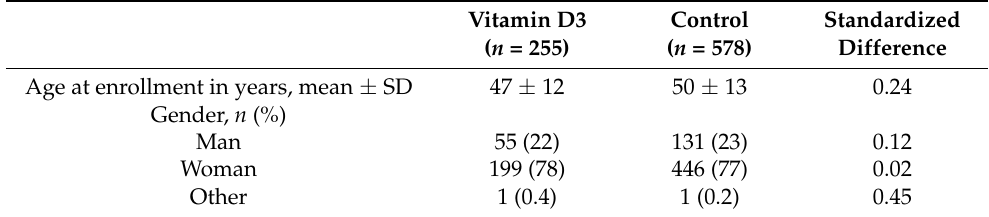
Table 2. Demographic and clinical characteristics of the vitamin D supplementation and control